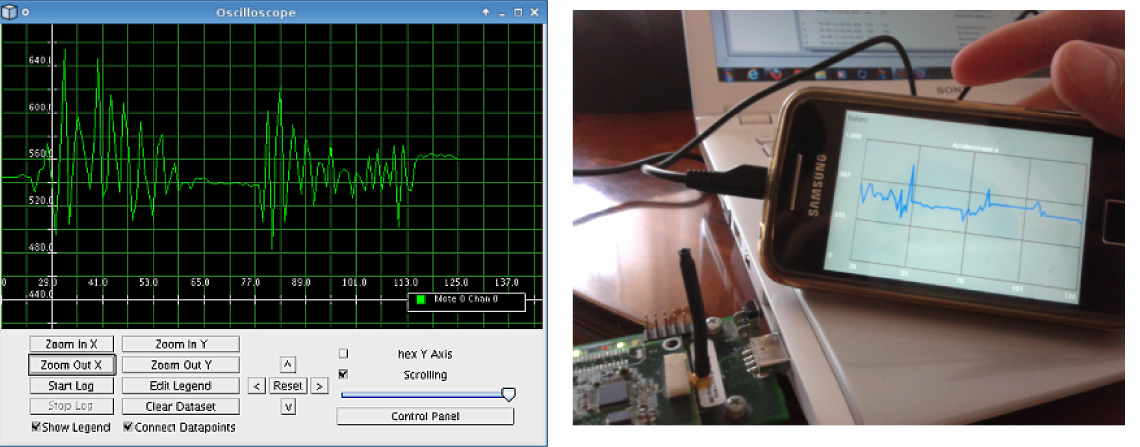
Figure 9. Data visualization in the Agilla Oscilloscope application and on USB connected Android